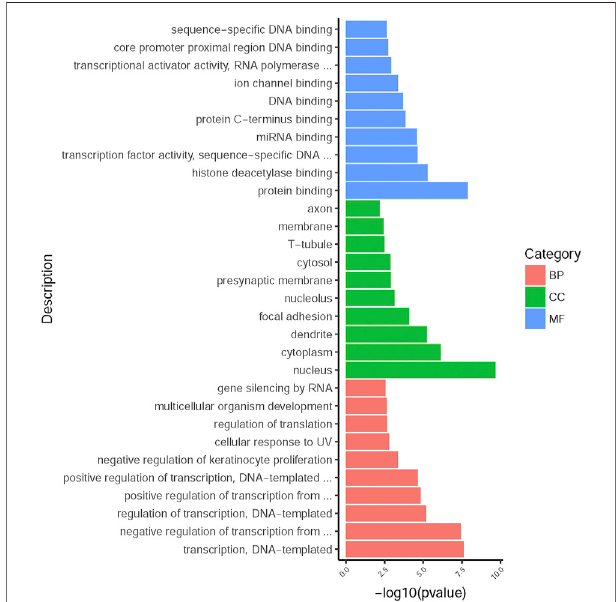
FIGURE 8 | GO annotation enrichment analysis. The top 10 high enrichment score terms in biological process, cellular components and molecular functions. GO: gene ontology; BP: biological process; CC: cellular components; MF: molecular functions.